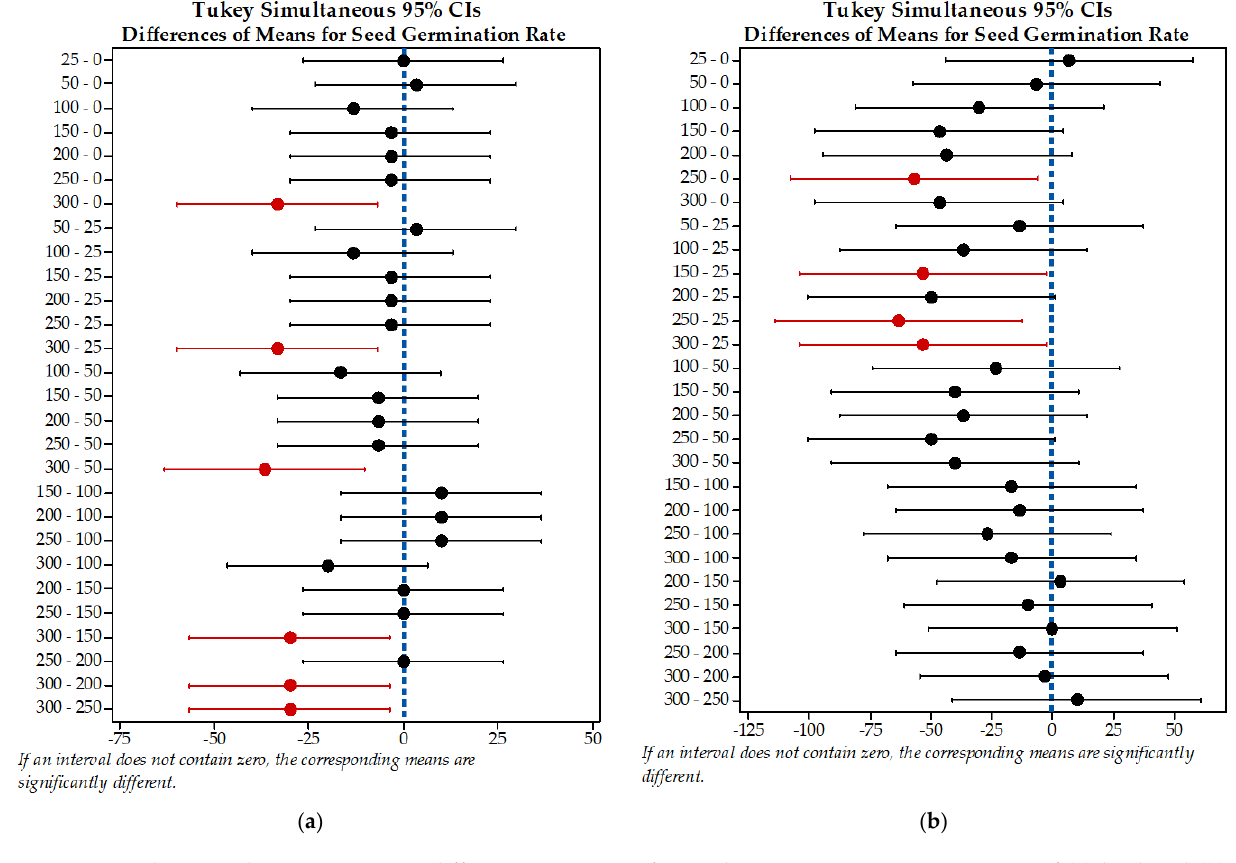
Figure 4. Tukey simultaneous 95% CIs differences in means for seed germination rate in presence of ( a ) lead and ( b ) cadmium (the intervals that do not contain zero are marked with red). The vertical blue dotted line indicates the point where the difference between the means is equal to zero, • estimated value of the difference between the means.